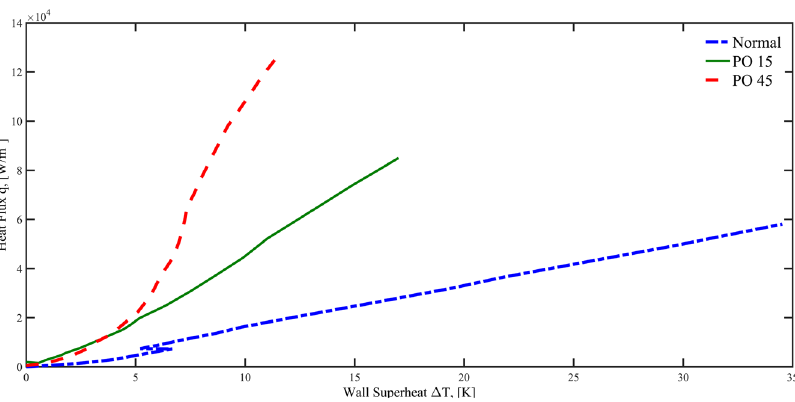
Figure 6. Boiling curves for the three surfaces during heated boiling